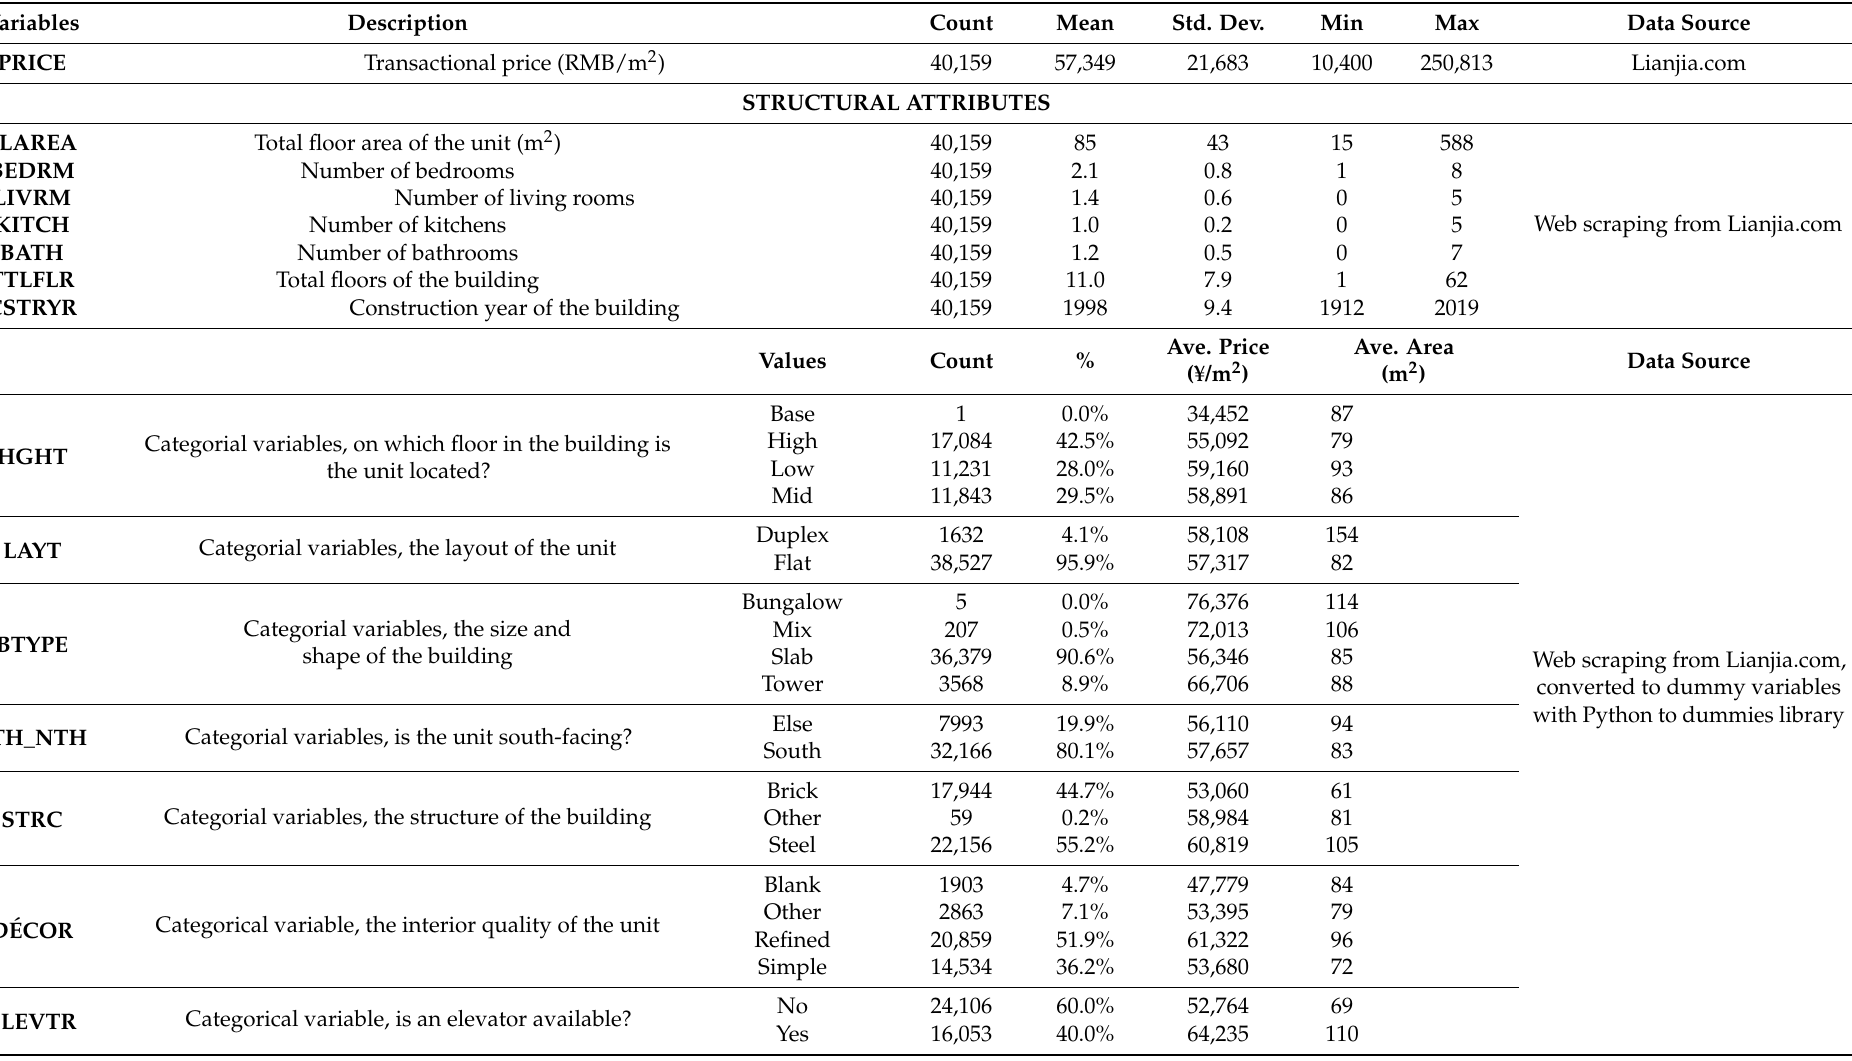
Table 2. General descriptive statistics of the housing